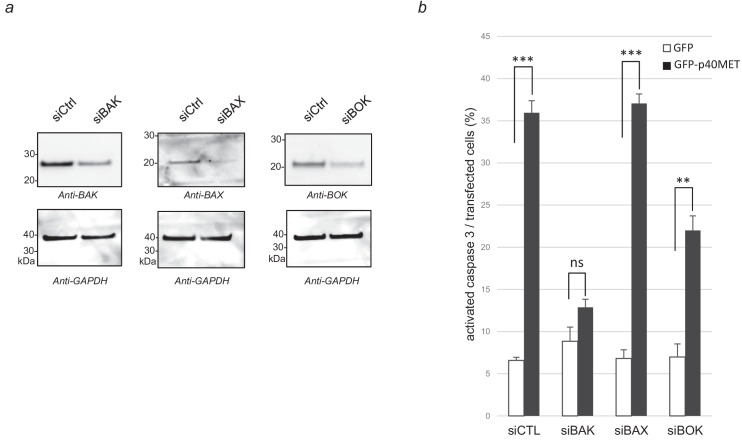
Effect of BAK, BAX and BOK silencing on p40MET-induced apoptosis in IHH cells.One day before transfection with a vector expressing either GFP or GFP-p40MET, IHH cells cultured on 12 well plates were transfected with a control siRNA or with siRNA targeting either BAK, BAX or BOK. Forty eight hours later, (a) one part of the cells was lysed and extracts were analyzed by western blotting with antibodies against BAK, BAX, BOK and GAPDH. (b) In parallel, immunofluorescence staining was performed with an anti-cleaved caspase 3 antibody and nuclei were labeled with Hoechst. The percentage cleaved-caspase-3-positive cells was determined with respect to the number of GFP-positive cells. At least 100 cells were counted per well (n = 3;± S.D.). ns, nonsignificant; **, p<0.01; ***, p<0.001 as determined by Student’s t test.Figure 2—figure supplement 2—source data 1.Source data of Figure 2—figure supplement 2b reporting counting of GFP and active caspase 3 positive cells, calculation of the percentage, mean and SD, diagram conception and statistical analyses.